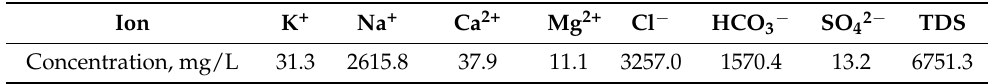
Table 1. Composition of the formation brine (Unit: